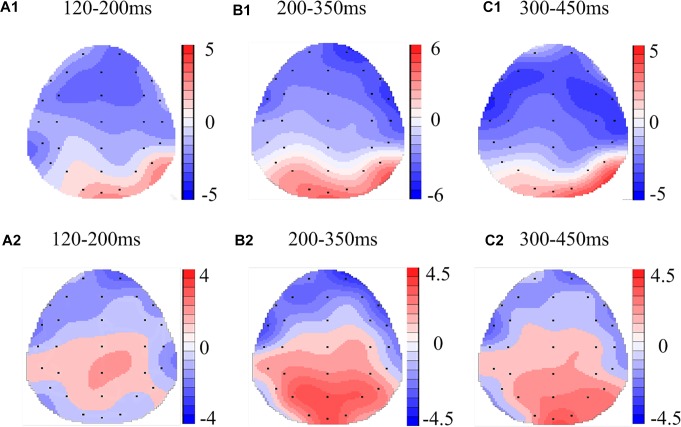
Topographic map of the differences between sleep conditions for Matching stimuli of working memory (A1–C2). Head plots of the paired t-test approach (two-tailed t-test, p < 0.05) map the scalp distribution of statistical differences of 36 h of total sleep deprivation (TSD) vs. 8 h time in bed (TIB) (A1–C1) and 8 h time in bed for recovery (TIBR) vs. TIB (A2–C2). Color bars indicate t-values. (A1) P200, 120–200 ms, in TSD vs. TIB. (B1) N200, 200–350 ms, in TSD vs. TIB. (C1) P300, 300–450 ms, in TSD vs. TIB. (A2) P200, 120–200 ms, in TIBR vs. TIB. (B2) N200, 200–350 ms, in TIBR vs. TIB. (C2) P300, 300–450 ms, in TIBR vs. TIB.